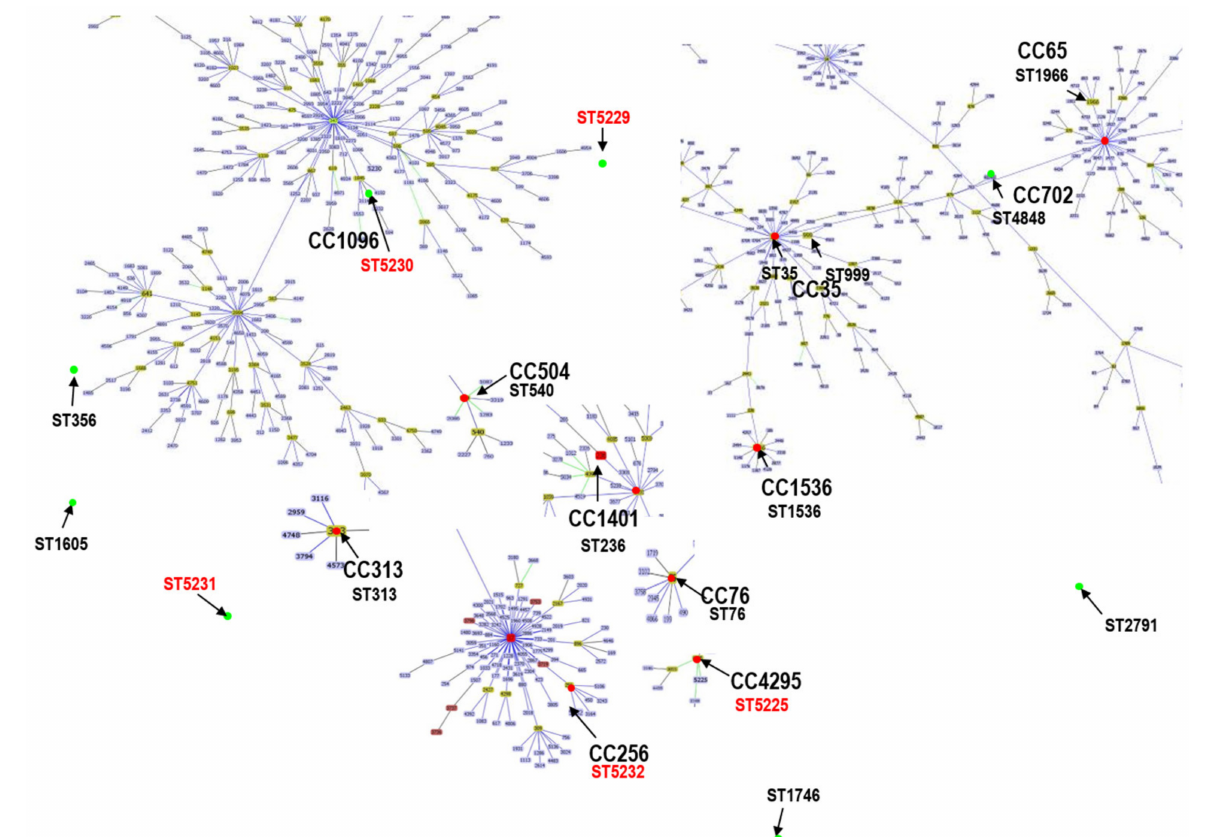
Figure 2. Population snapshot of all KpnC isolates typed in current study using goeBURST analysis compared to entire database of K. pneumoniae MLST isolates (8 November 2020). Black letters indicate matching of KpnC STs in this study with database entries. Green dots indicate individual founders. Different clonal complexes are shown. ST5225 and ST5229–ST5232 are novel STs identified in this study and are shown in